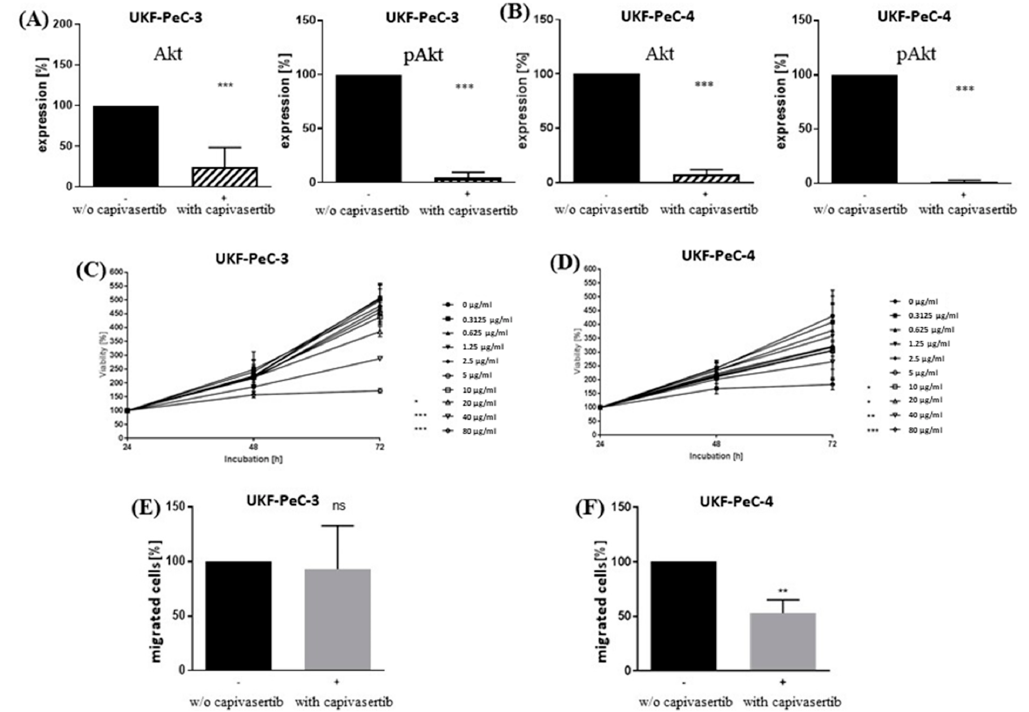
Figure 5. Molecular and functional effects of cell treatment with capivasertib. ( A , B ): Western blot analysis of AKT and pAKT after treatment with 20 mol/L capivasertib for 72 h for UKF-PeC-3 and UKF-PeC-4 cells, respectively. Cell number set to 100% after 24 h incubation. ( C , D ): Tumor cell growth of UKF-PeC-3 and UKF-PeC-4 cells after 24, 48, and 72 h exposure to capivasertib [0.3125–80 µg/mL], respectively. ( E , F ): Serum-induced chemotaxis of UKF-PeC-3 and UKF-PeC-4 cells after treatment with 20 mol/L capivasertib for 72 h, respectively. Cell number set to 100% after 24 h incubation. Error bars indicate standard deviation (SD). Significant difference to untreated control: * p ≤ 0.05, ** p < 0.01, *** p ≤ 0.001. n = 4.